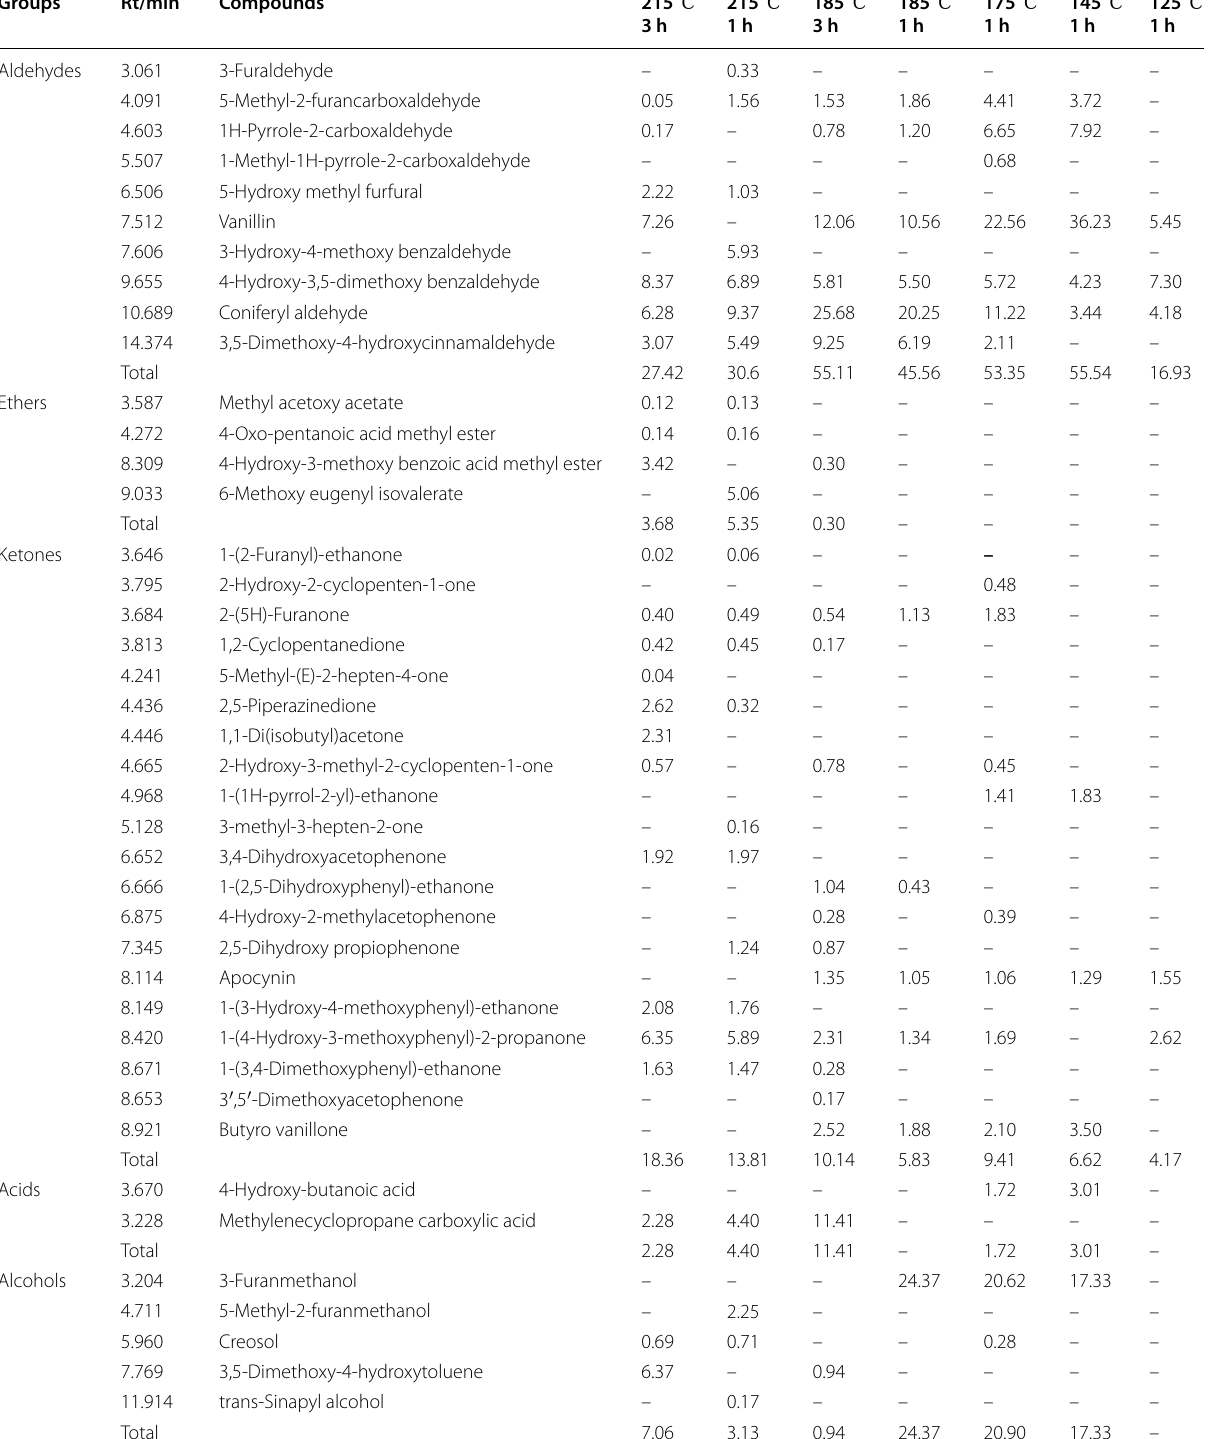
Table 1 Relative amounts of the effluents condensated by VOCs of rubberwood from different heat-treatment stages Groups Rt/min Aldehydes